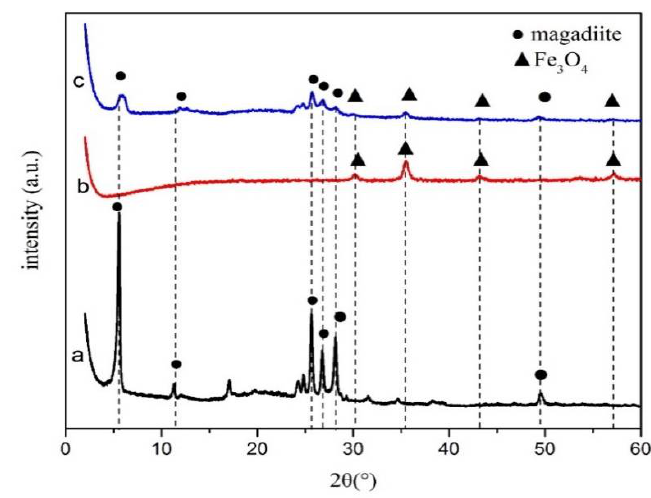
Figure 1. XRD patterns of ( a ) MAG, ( b ) Fe 3 O 4 , and ( c ) MAG–Fe 3 O 4 .